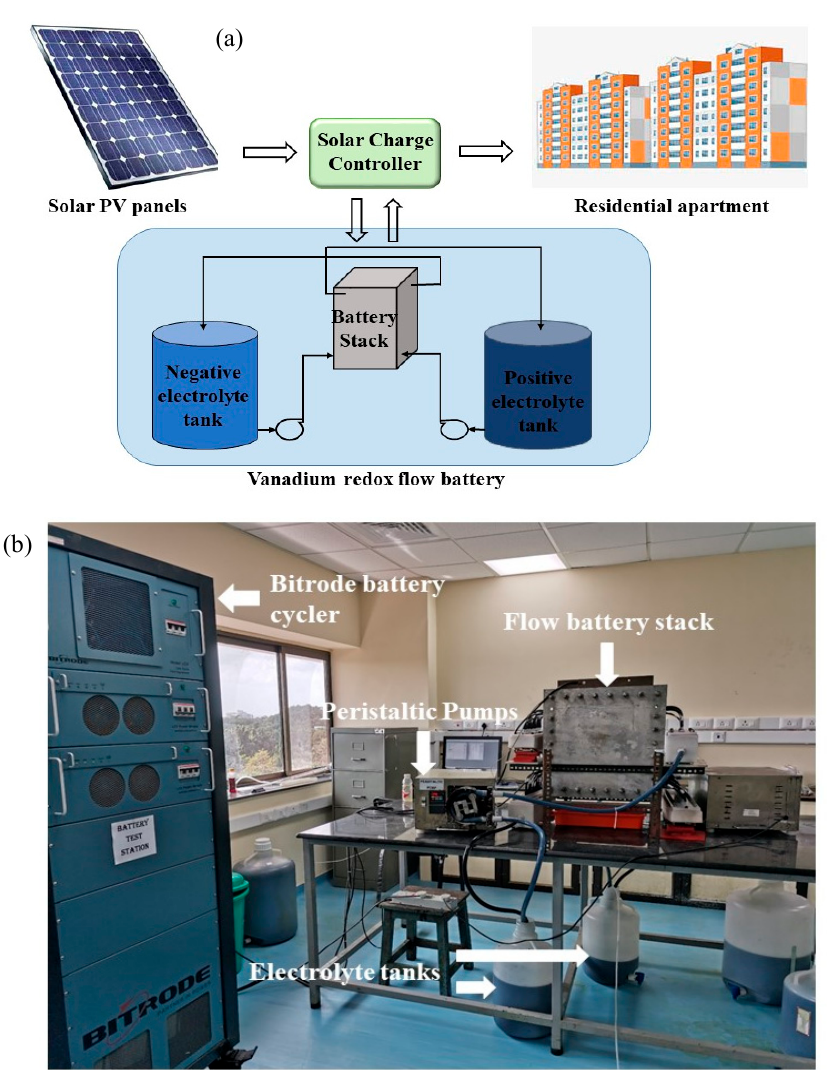
Figure 1. ( a ) Schematic diagram of the solar PV-flow battery-residential load integrated system. ( b ) Modelled system for the experimental study.